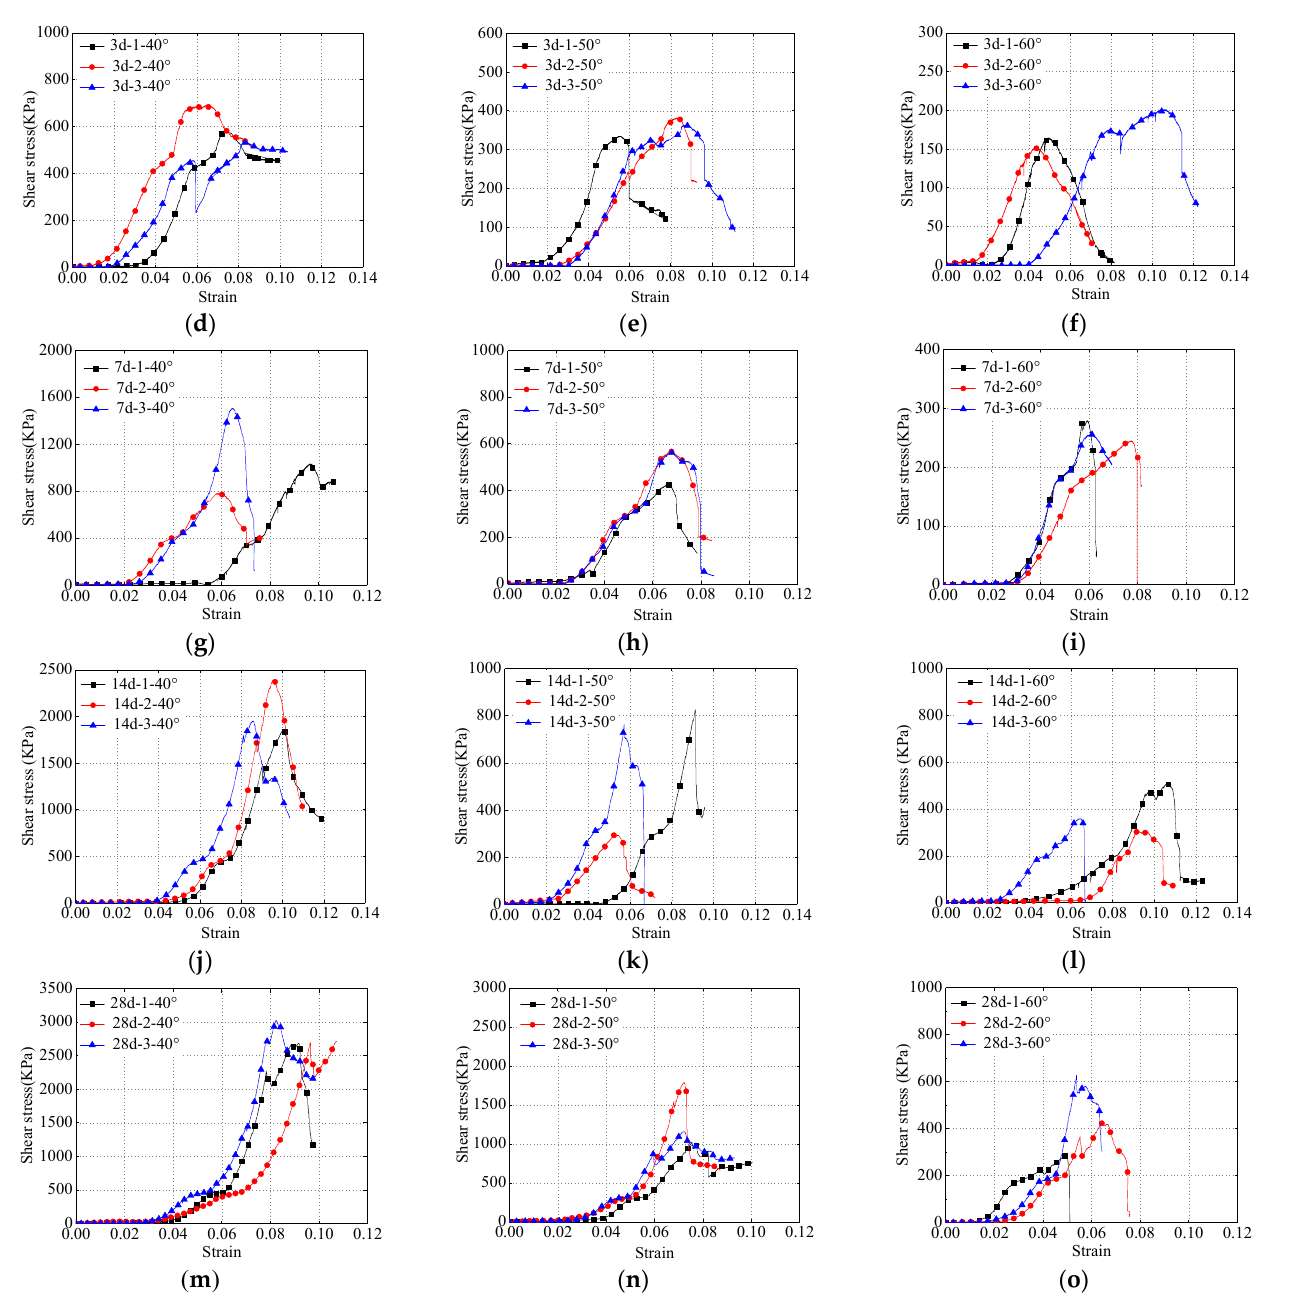
Figure 12. Stress stress–strain curves at different shear angles (40° ( a , d , g , j , m ), 50° ( b , e , h , k , n ) and 60° ( c , f , i , l , o )). According to the experimental results plotted in Figure 12 and listed in Table 5, the shear strength of shotcrete specimens dropped with the shear angle at any curing age. This is because, as the shear angle increased, the shear force inside the shotcrete specimen increased, leading to the shear damage of the specimen. The shear force inside the specimen was small at a small shear angle. The specimen was subject to the combined action of shear strength and compressive strength. For this reason, the larger the shear angle, the smaller the shear strength. As shown in Figure 13, at different shear angles, the orientation of crack propagation also varied. At a larger shear angle, several cracks appeared in the specimen along the shear direction. This indicated that the shear strength of the shotcrete specimen increased at a larger shear angle. Moreover, the glass fibers had a bridging effect inside the shotcrete specimen, which further enhanced the anti-shear effect in the speci- men.